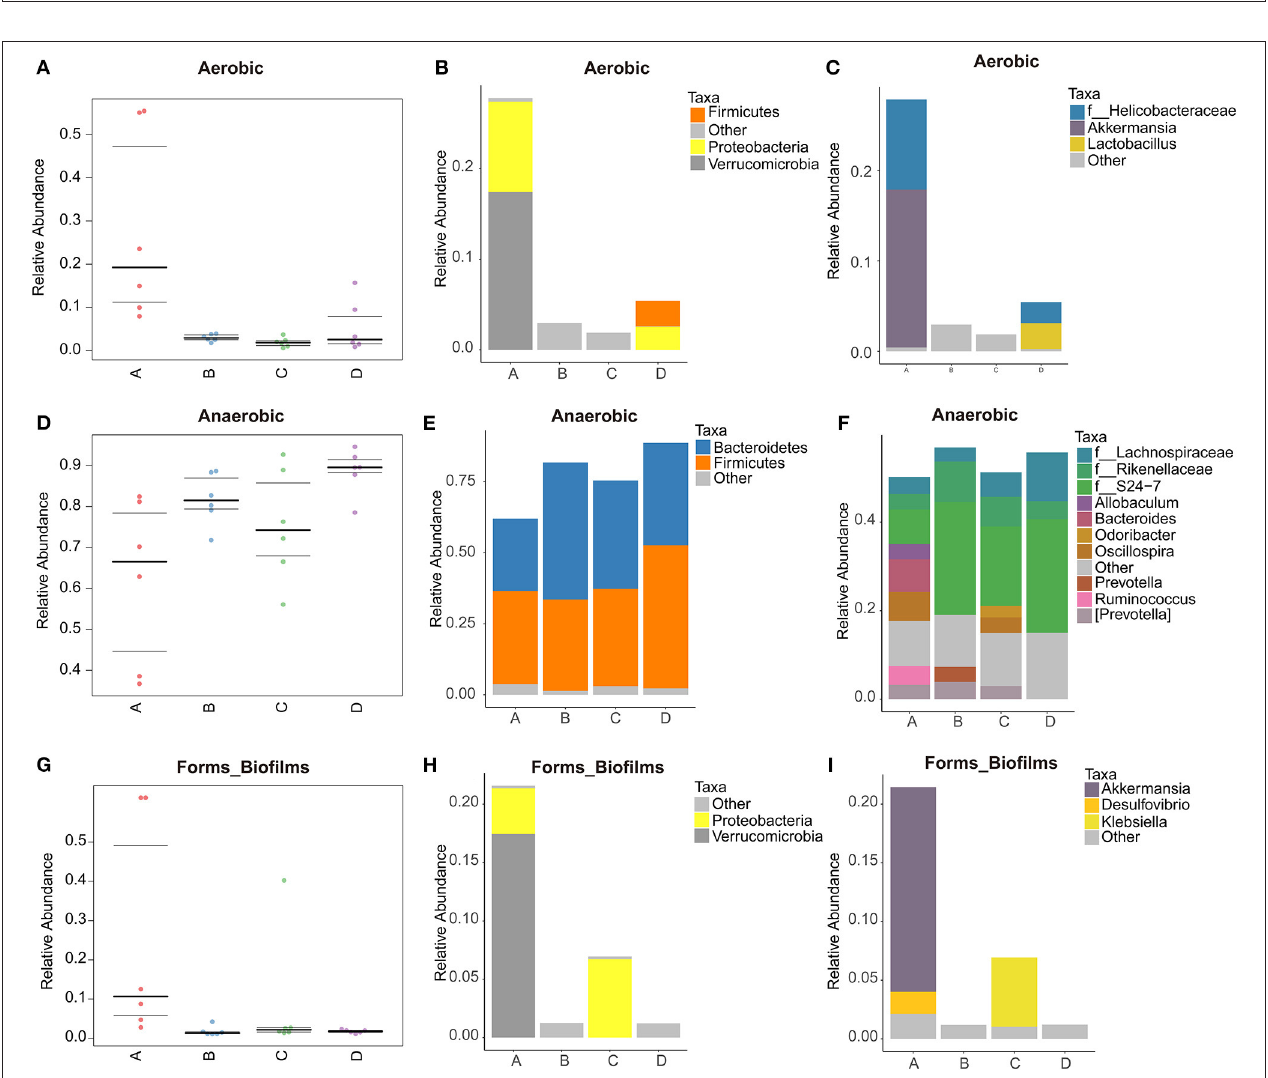
FIGURE 5 | D: model control group. In the evolutionary branching diagram, the circle radiated from inside to outside represented the taxonomic level from phylum to species. The diameter of the small circle was proportional to the relative abundance. The species with no significant difference was represented by yellow, and the other species with the highest abundance were colored according to the group with the highest abundance.